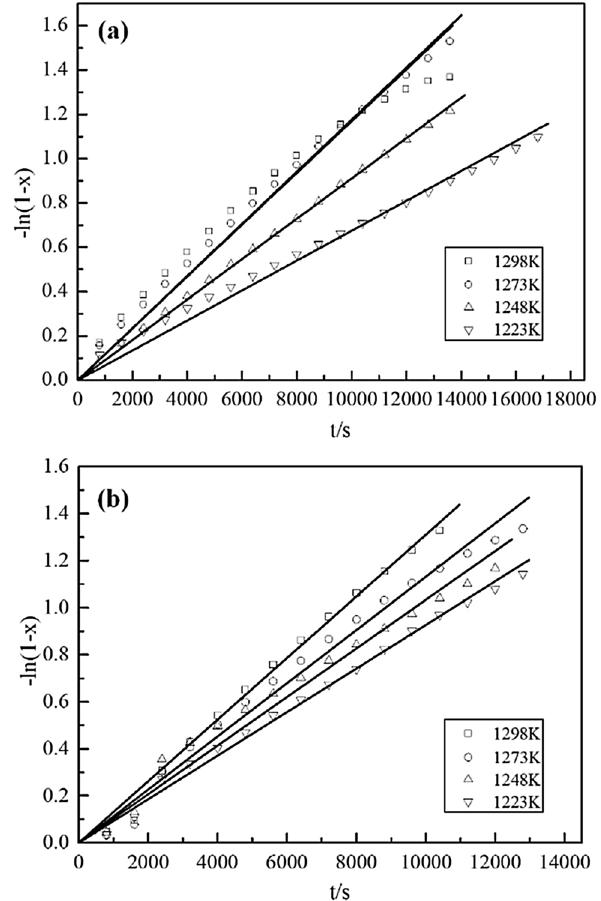
Fig. 7 Shrinking core model for a raw coke samples and b samples adsorbed Na 2 CO 3 at different